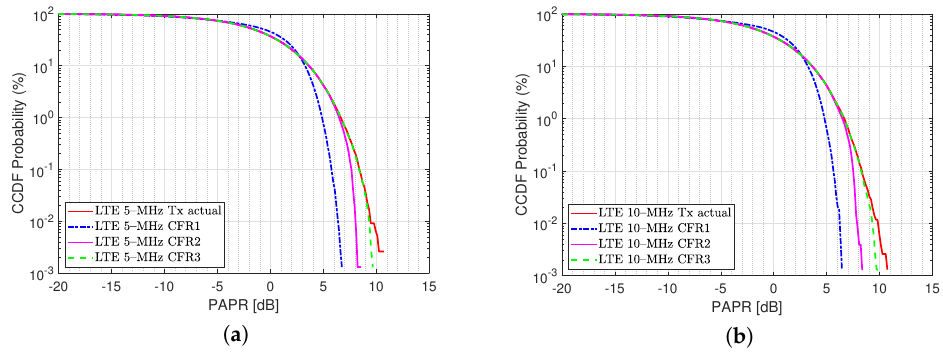
Figure 11. CCDF of OFDM signal; ( a ) CFR iterative factor for LTE 5-MHz waveform and ( b ) LTE 10-MHz